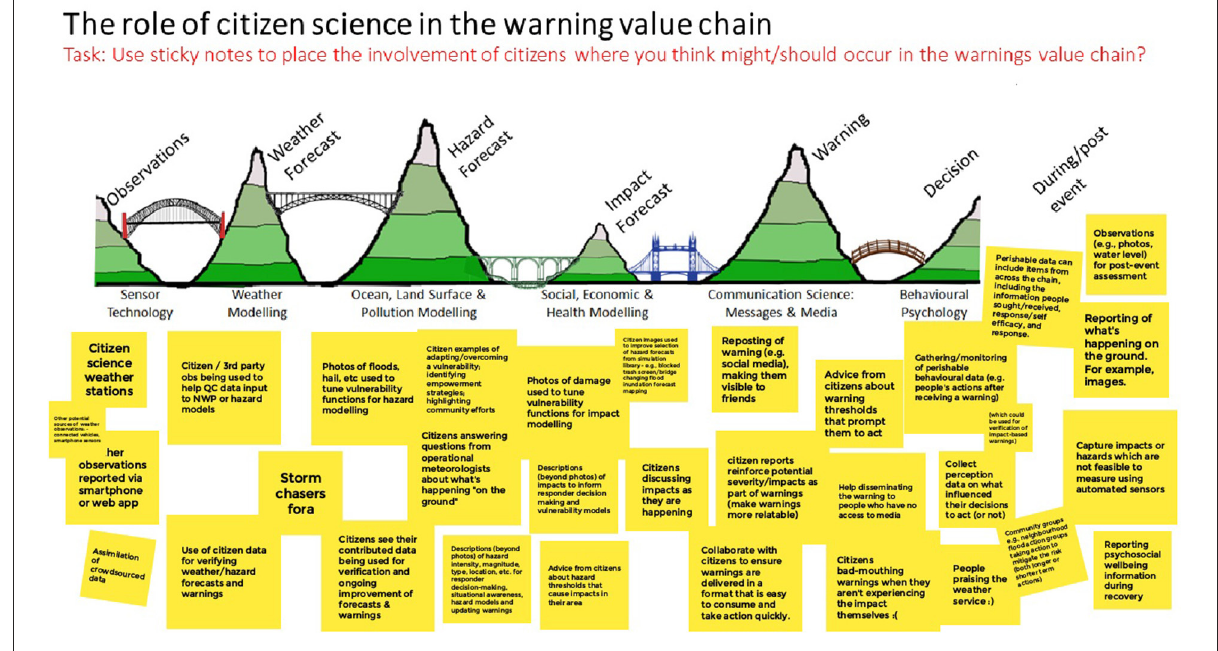
FIGURE3 Pre-workshop online collaborative board with yellow sticky notes showing the responses provided by